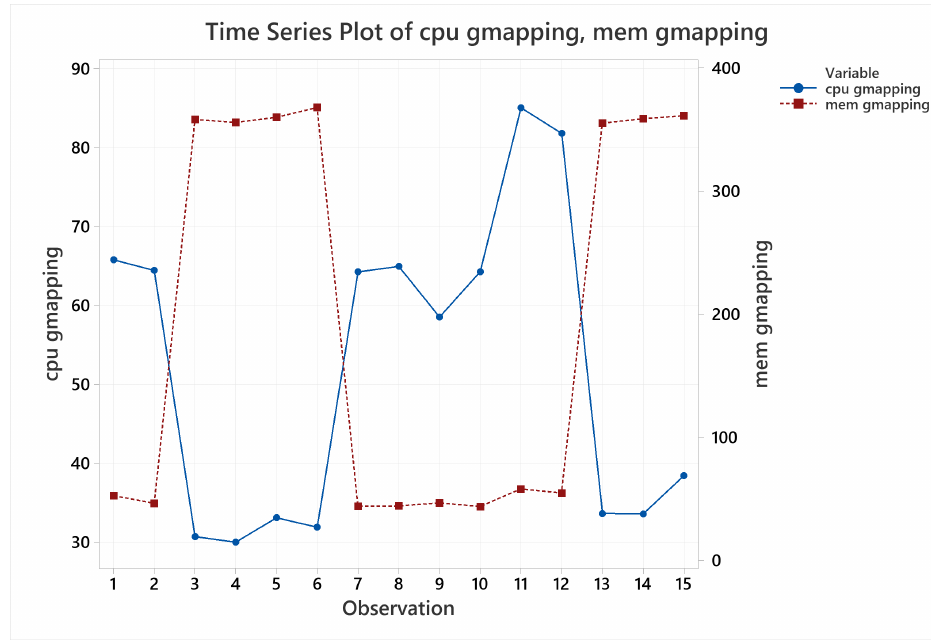
Figure 17. CPU and memory usage mean behavior for